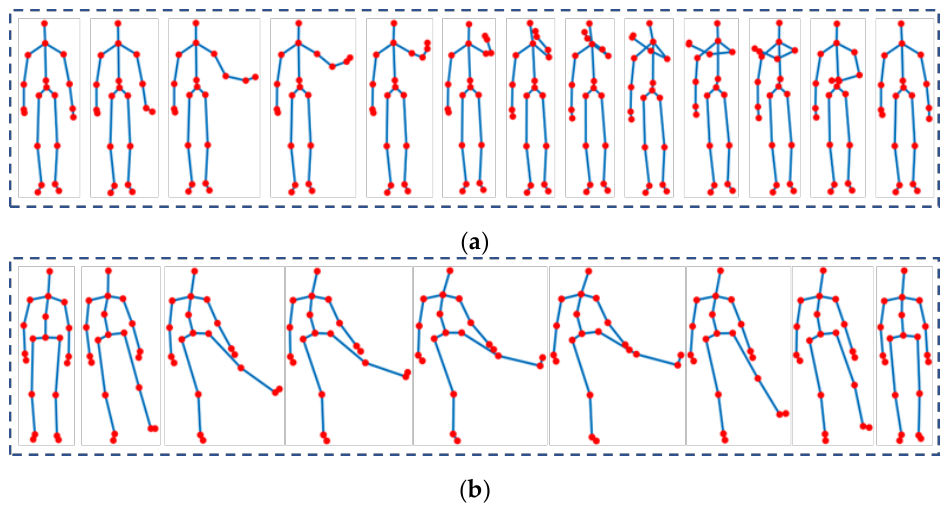
Figure 8. Examples of actions in skeleton datasets: ( a ) SwipeLeft in UTD-MHAD dataset; ( b ) SideKick in MSR-Action3D dataset.